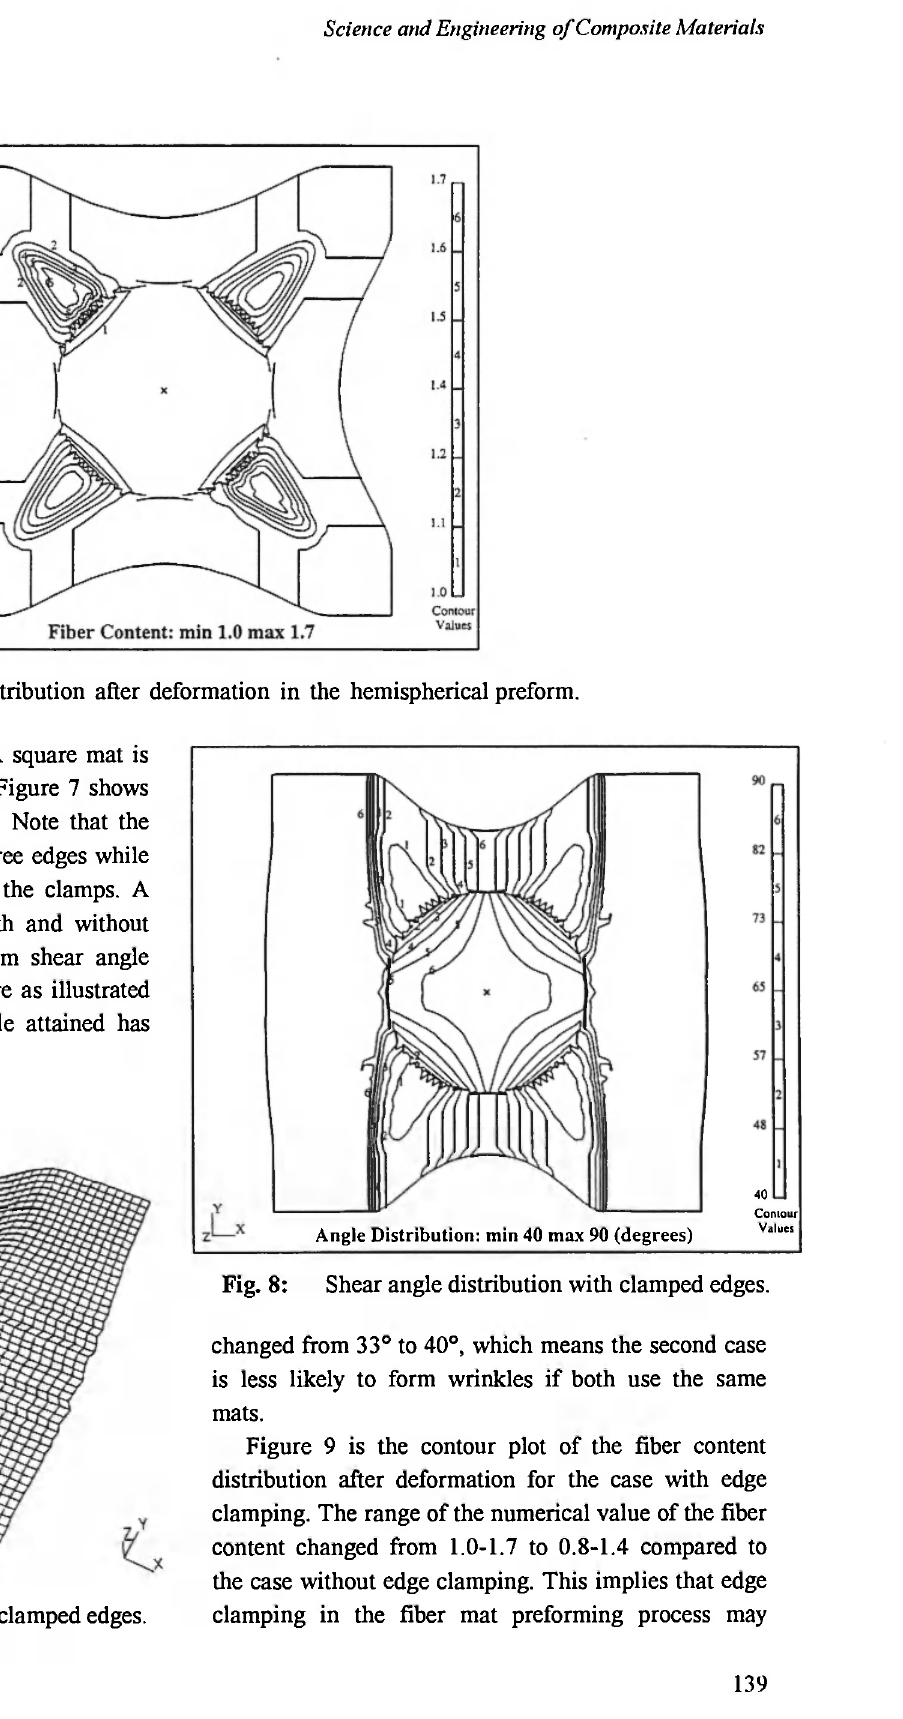
Fig. 7: Deformed configuration with clamped edges.